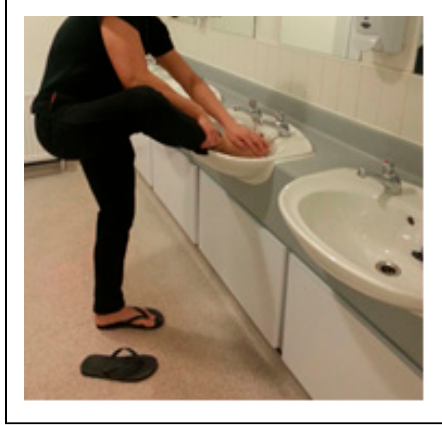
Figure 2. Photograph taken by Arif’s friend of his ablutions.